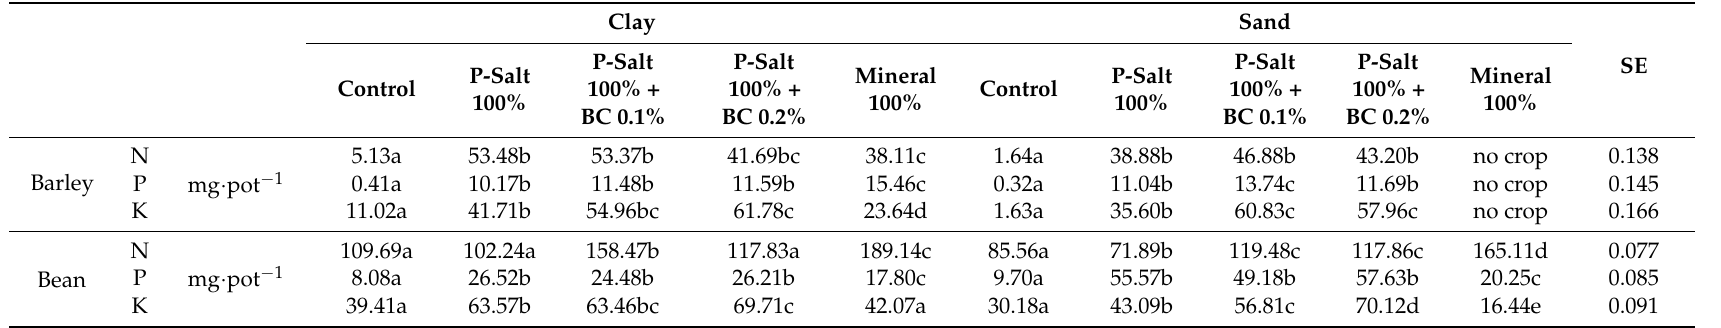
Table 8. Mean nutrient uptake into shoots for fertilizer forms with/without biochar (BC) addition tested. Different letters in the table indicate statistically significant differences between treatments ( α = 0.05, n = 4).